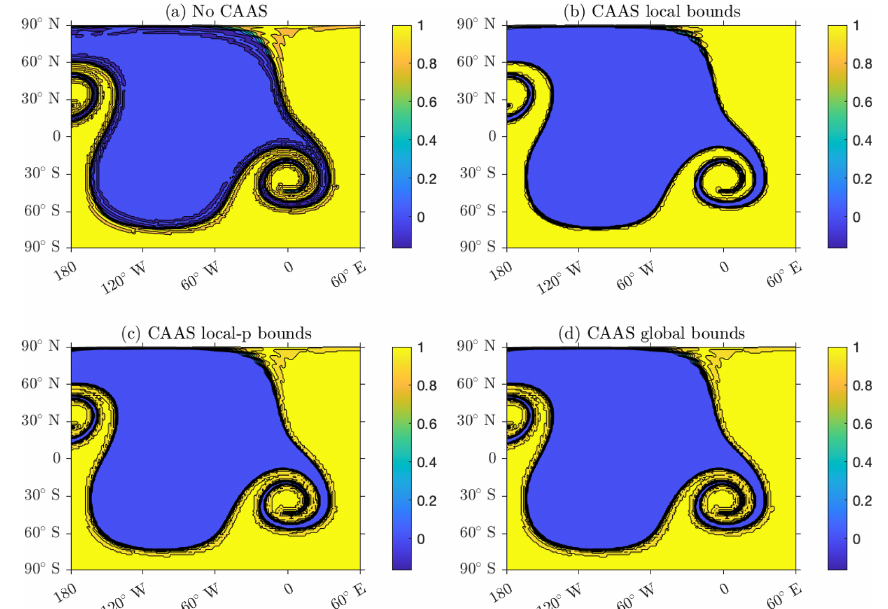
Figure 5. The Gibbs oscillations for a finite-volume to finite-volume remapping from a resolution 60 cubed sphere to a 1 ◦ latitude–longitude mesh, with fourth-order polynomial reconstruction. Panel (a) shows the results without CAAS, panel (b) shows the results using CAAS with local bounds preservation, panel (c) shows the results using CAAS with local- p bounds preservation, and panel (d) shows the results using CAAS with global bounds